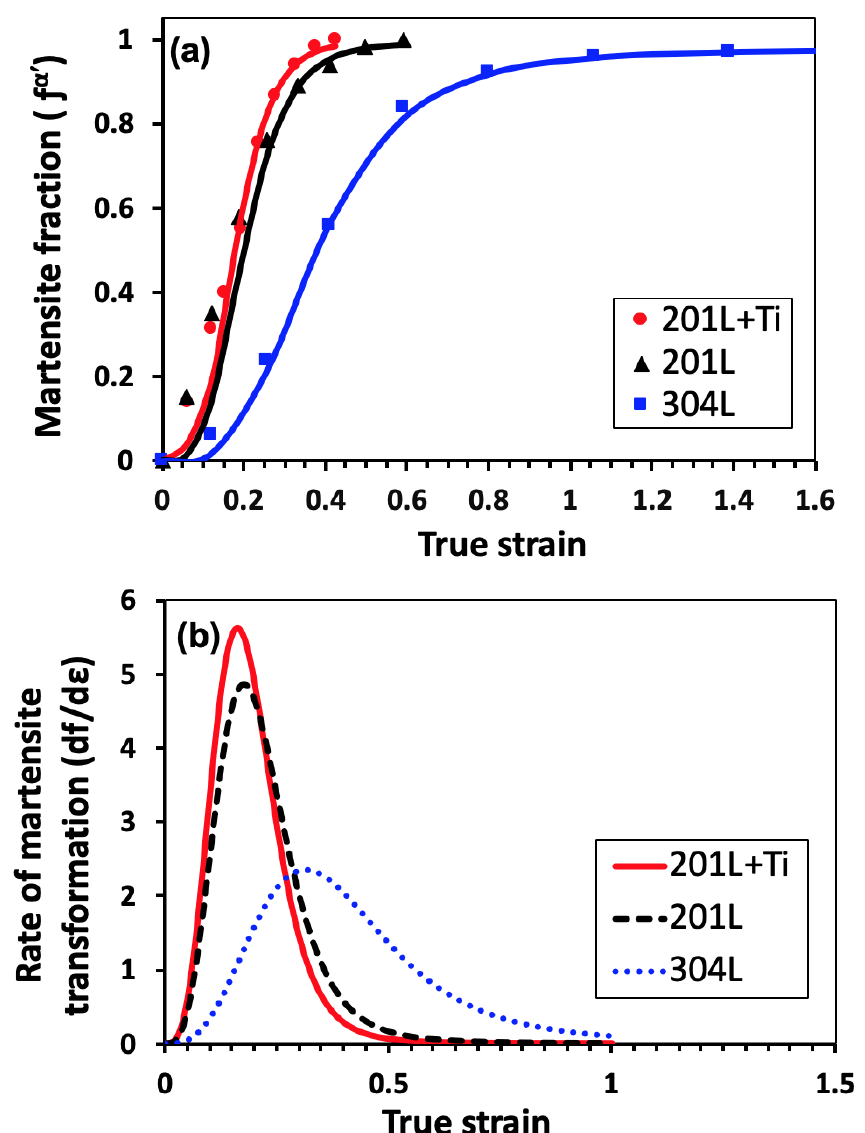
(cid:48) ) as a function of true strain for 304L, 201L and 201L + Ti